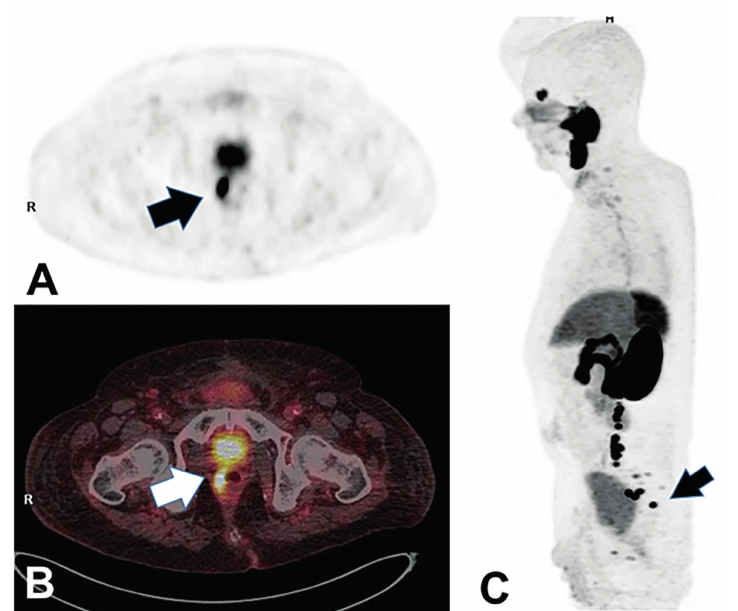
Figure 2 - Rectal